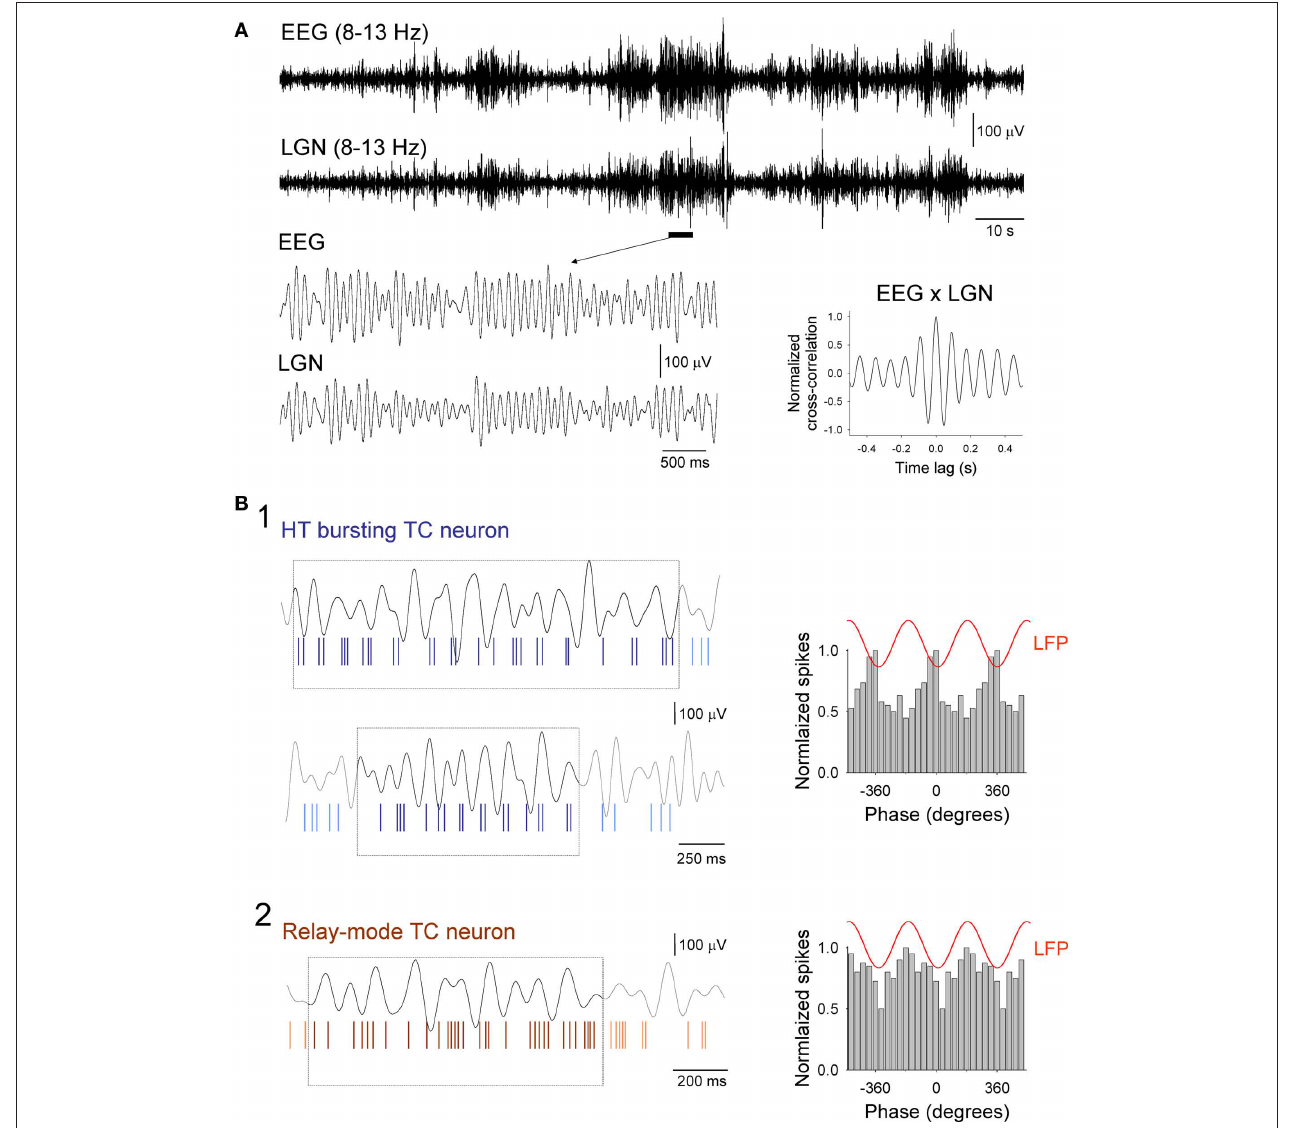
spikes predominantly occur close to the negative peaks of the LFP (top panel) although they can also occasionally switch to occurring near the positive peaks (lower panel). The corresponding spike-timing histogram for several consecutive α rhythm epochs is shown to the right. The red trace above this plot is a schematic representative of the oscillatory signal in the LFP. (B2) Activity of a relay-mode LGN TC neuron during a brief α rhythm epoch (identified by the box). Again, the top trace is the LGN LFP. The corresponding spike-timing histogram for several consecutive α rhythm epochs is shown to the right and reveals that firing in this neuron is suppressed close to the negative LFP peak (for additional details relating to the activity of LGN TC neurons during α rhythms see Lorincz et